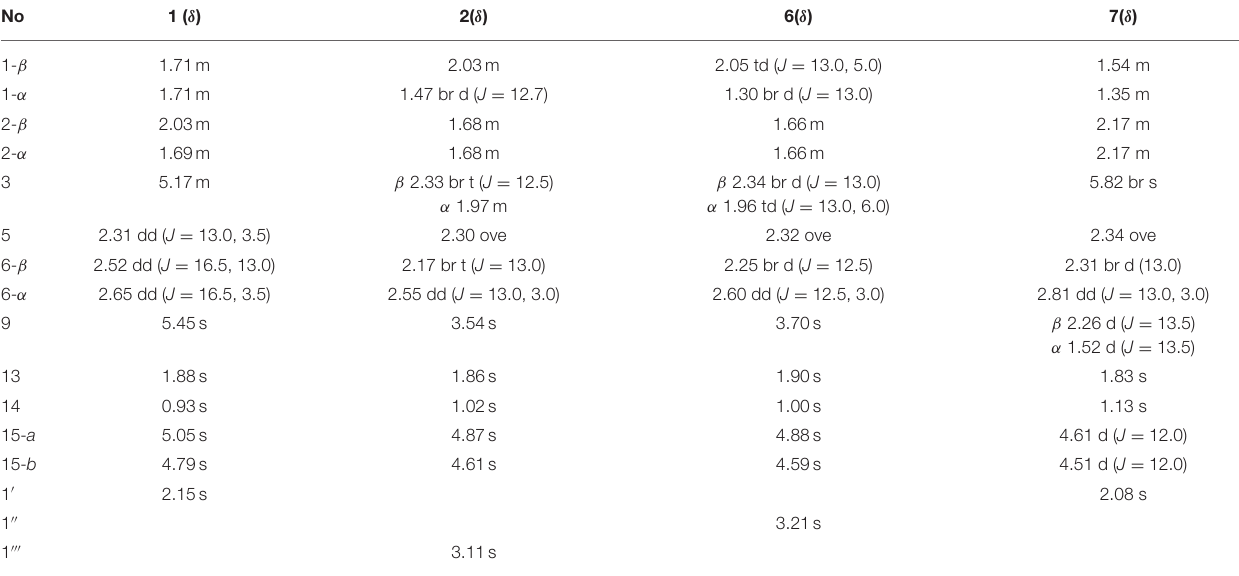
TABLE 1 | 1 H NMR (500 MHz) data for new compounds 1 , 2 , 6 , and 7 in CDCl 3 solvent ( δ in ppm, J in Hz) a .